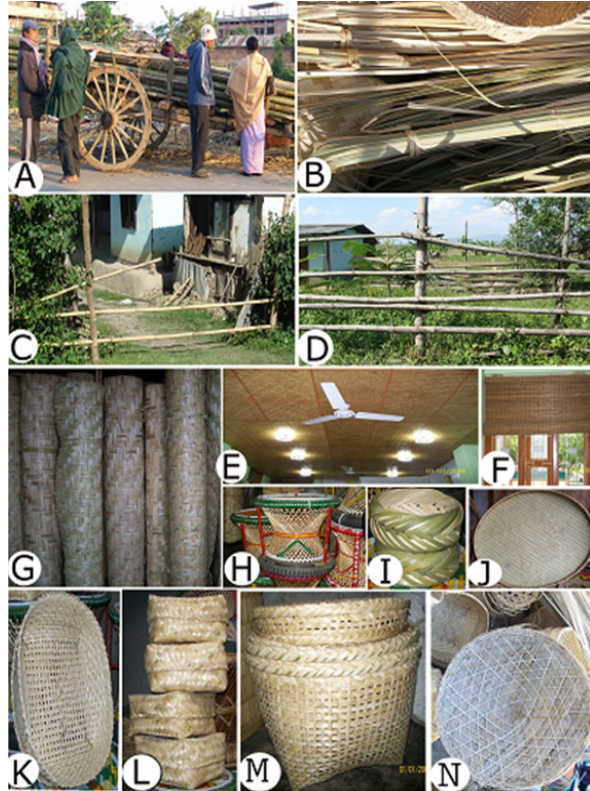
Fig. 2. Various uses of Bambusa tulda and potential commercial products: A. Bamboo culms at sell; B. Paya and Wachet sold as raw material; C. Konthong ; D. Sambal ; E.Ceiling made of bam- boo; F. Bamboo shutter used as curtain; G. Faklong ; H. Mora ; I. Feija ; J. Yangkok ; K. Kharai ; L. Ngarubak ; M. Polang ; N. Chak-